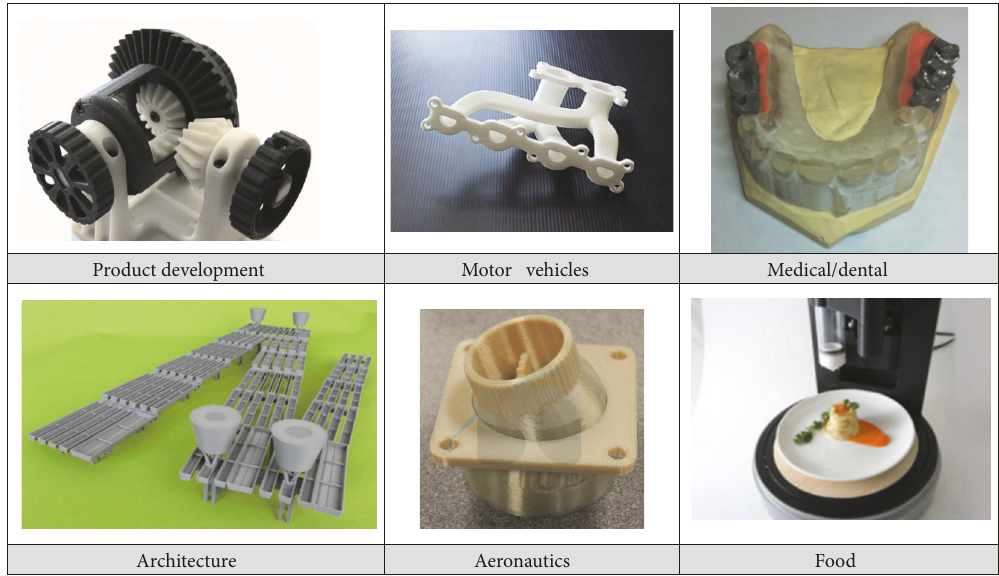
Figure 8: AM applications.